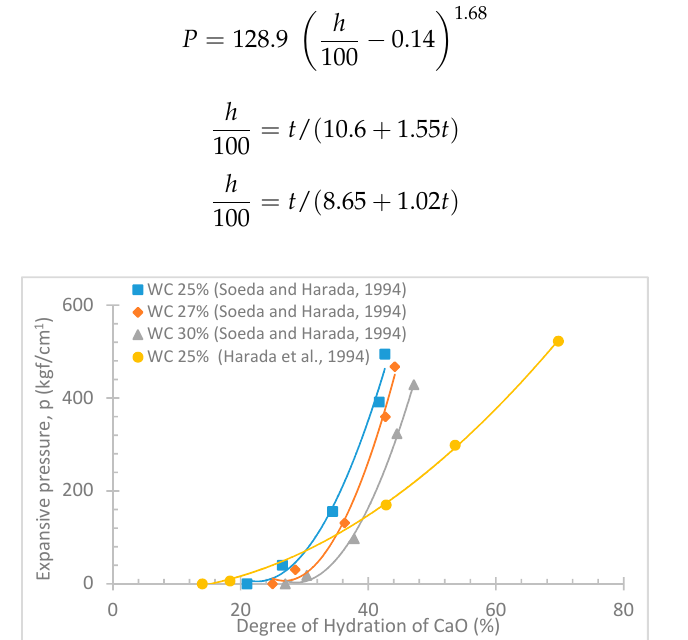
Figure 3. Variation of expansive pressure generated with degree of hydration [37,51].